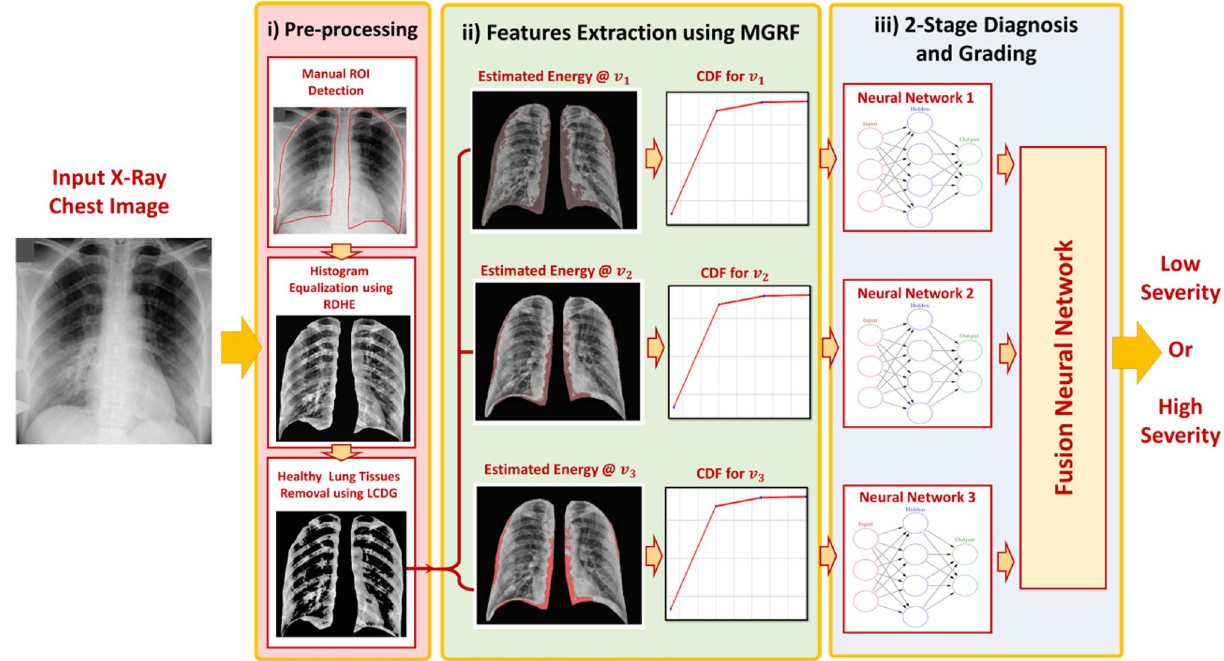
Figure 1. The pipeline of the proposed CAD system for COVID-19 diagnosis and